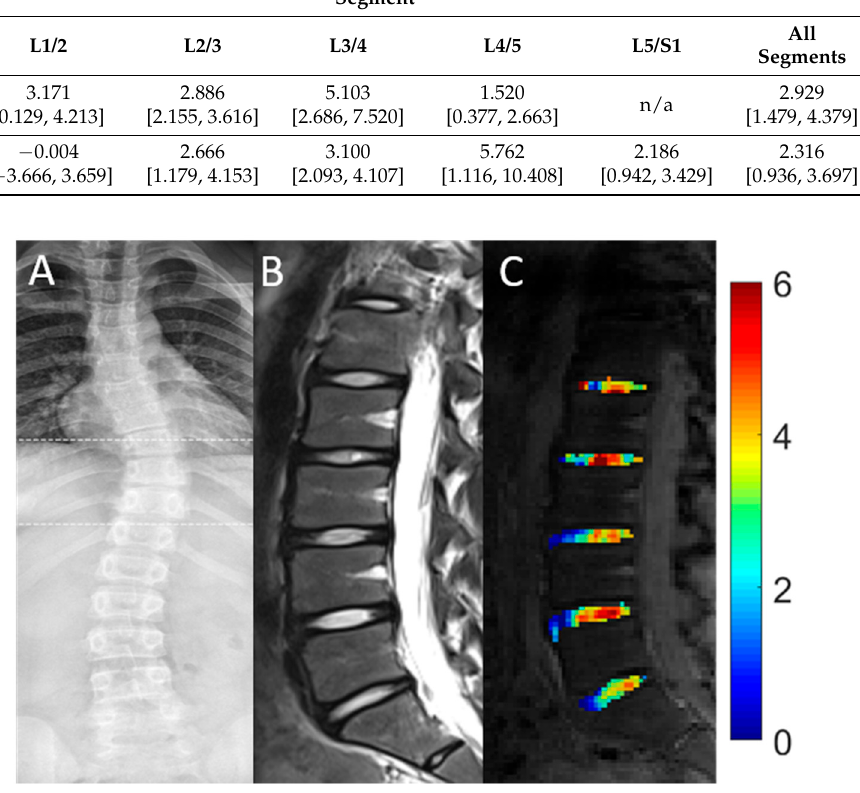
Figure 2. Representative conventional radiograph ( A ) and morphologic ( B ) and compositional ( C ) imaging findings of the spine of a 15-year-old female patient. ( A ): Conventional whole-spine radiograph in coronal orientation reveals the extent of the scoliotic curve. ( B ): Sagittal T2-weighted image indicates the absence of significant degenerative changes of the lumbar IVDs. ( C ): Sagittal gagCEST images with overlaid color-coded gagCEST maps to illustrate the GAG content indicates that no significant differences of the GAG content are seen in scoliotic compared to non-scoliotic